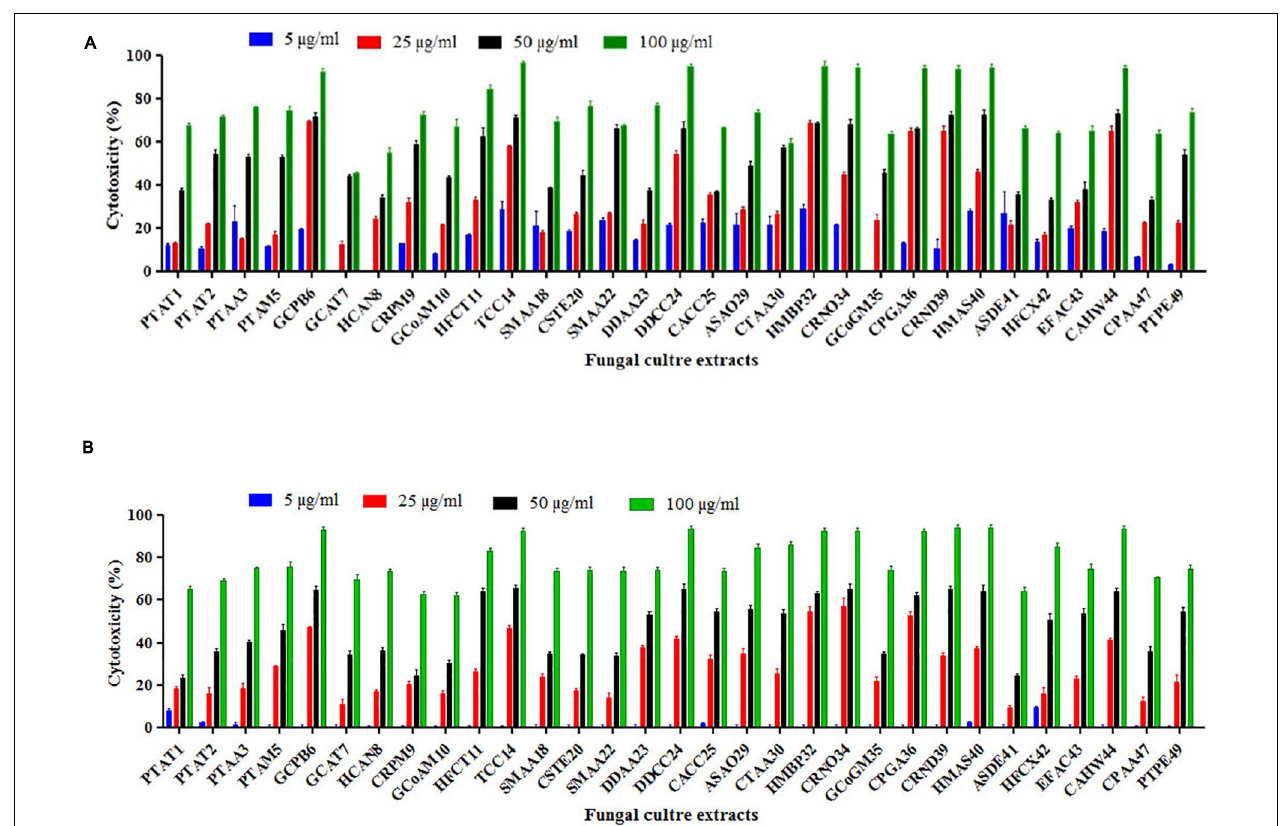
FIGURE 2 | (A,B) In vitro cytotoxicity of fungal ethyl acetate extracts on human cancer cells HeLa and A431.